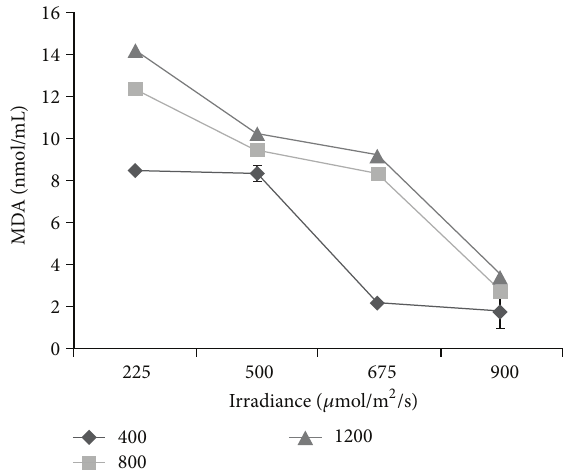
Figure 5: Interaction effects of CO 2 levels and irradiance on lipid peroxidation DPPH of Labisia Pumila ; 𝑁 = 21 . Bars represent standard errors of differences between means